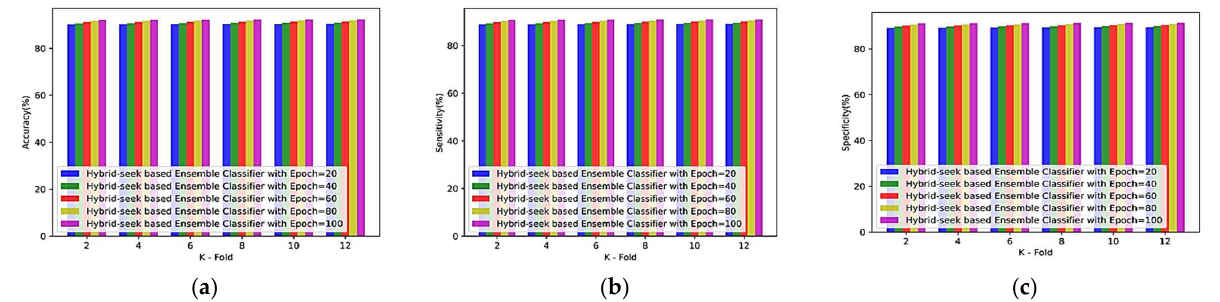
Figure A4. Analysis of performance using the Siena database in terms of k-fold values ( a ) accuracy, ( b ) sensitivity, and ( c ) specificity.